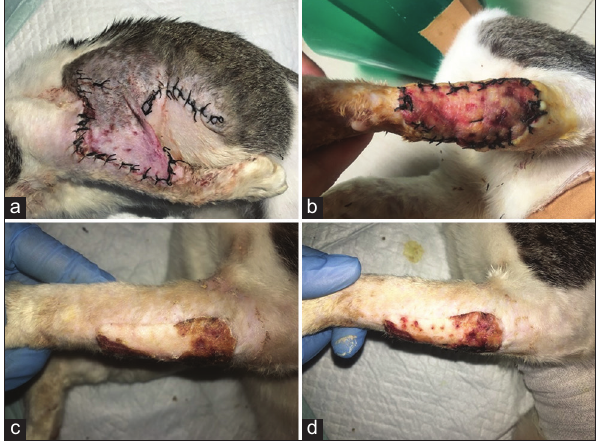
Skin donor figures during post-surgery treatment. (a) Skin donor condition on day 3; (b) skin donor condition on day 9 cutting of the skin flap from donor site area; (c) skin donor condition on day 12; and (d) skin donor condition on day 24 after distant flap surgery.(b-d) After cutting of the skin flap from donor site area.